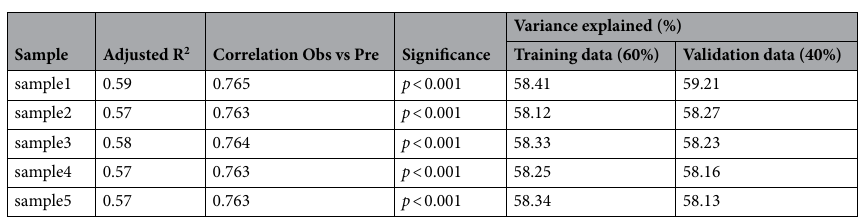
Table 7. Adjusted R 2 and correlation between observed (Obs) and predicted (Pre) values in MLR.